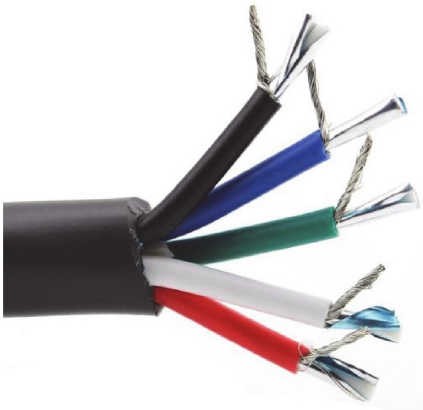
Figure 1: RGB color